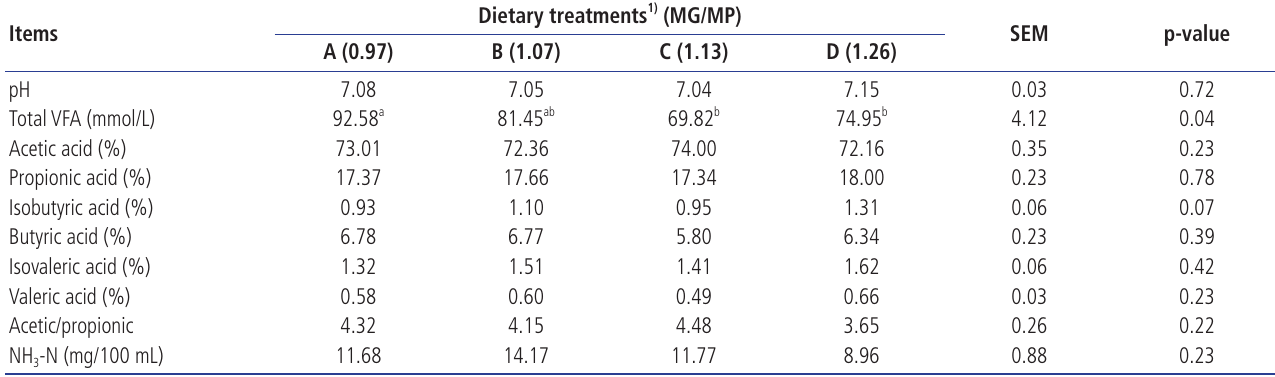
Dietary treatments 1) (MG/MP)